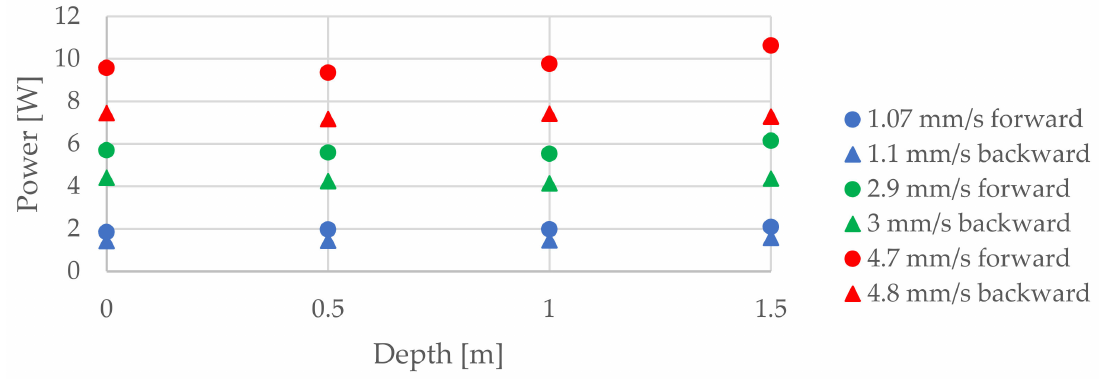
Figure 19. Power measurements at different depths and